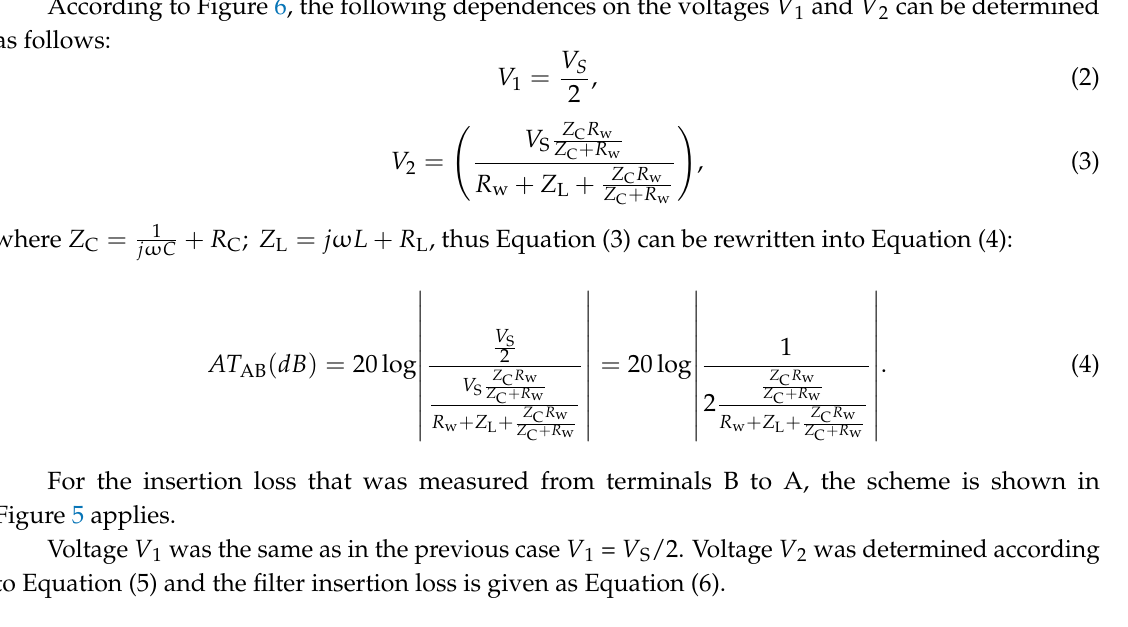
Figure 6. Circuit schemes for which the V 1 and V 2 voltages were required to determine the filter insertion loss from Terminals A to B: ( a ) system without a filter to determine voltage V 1 and ( b ) system with a filter to determine voltage V 2 .